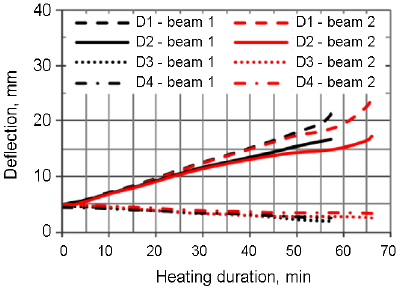
Fig. 5. Deflection of the beams: D1, D2 – at heated span, D3, D4 – at not heated span (sensor s location – see Fig. 2)